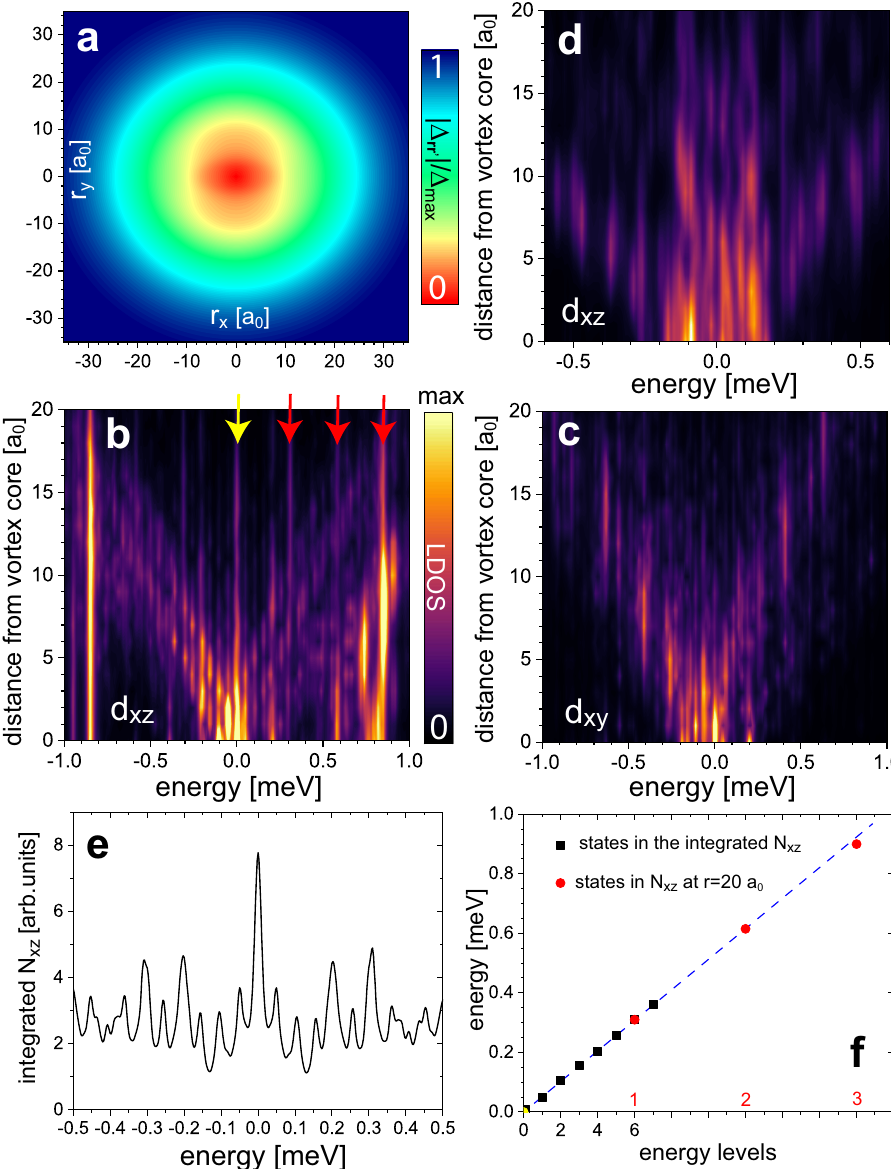
Fig. 2 Majorana zero mode in a vortex core. a Spatial dependence of the superconducting order parameter in the d xz -orbital near a vortex core for a magnetic fi eld of B = 2T. Color bar represents the normalized superconducting order parameter. Linecut of the orbitally-resolved local density of states, N a ( r , E ), through the center of the vortex core along the x -axis for the b d xz -, and c d xy -orbital in the topological phase with Chern number C = − 1 and ( JS , α , Δ μ xz , Δ μ yz , Δ μ xy ) = (7.5, 7, 4, 4, 1) meV (the Majorana zero mode is indicated by a yellow arrow). Here, α is the Rashba spin – orbit coupling, and JS is the magnetic exchange strength. Color bar represents the normalized local density of states. d Linecut of the orbitally-resolved local density of states, N E ), through the center of the vortex core along the x -axis for the d a ( r , For the C = − 1 topological phase (same parameters as in b , c ): e Radially integrated local density of states for the d xz -orbital. f Energy position of the of the low energy states, as revealed by the peaks in the local density of states in ( e